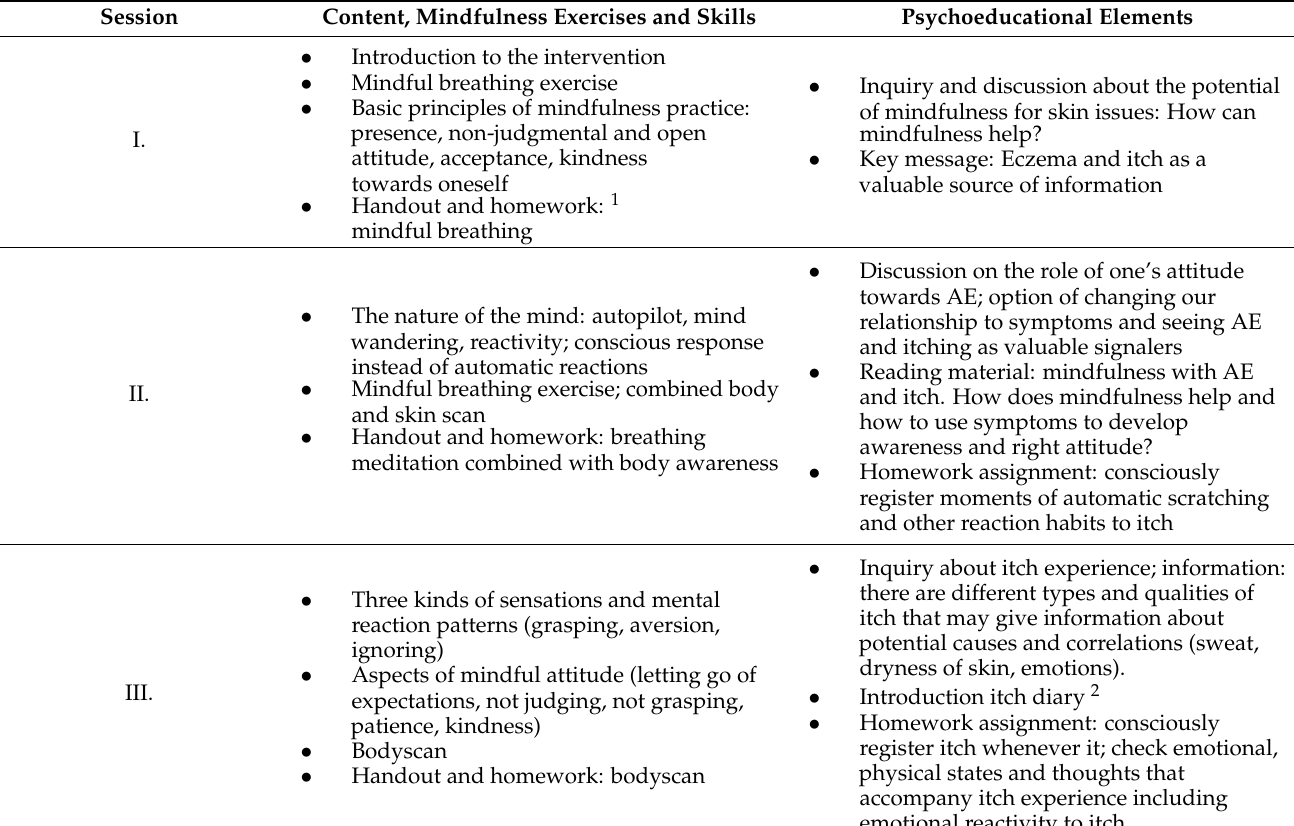
Table A1. Structure and Content of the MBTSC